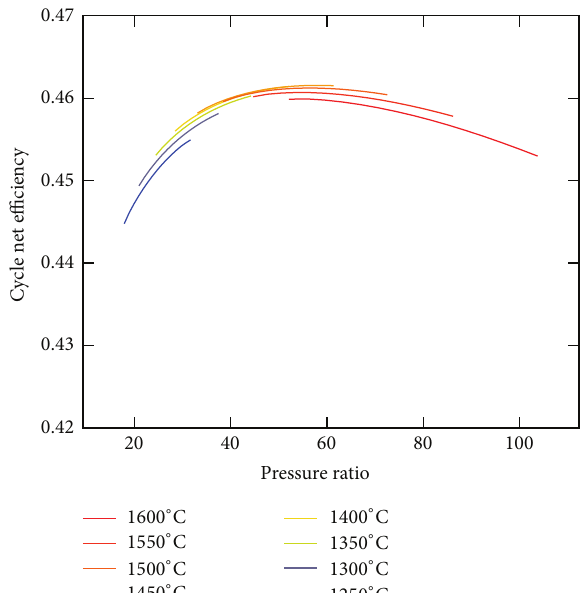
Figure 7: Net efficiency as function of pressure ratio and turbine entry temperature for the SCOC-CC.